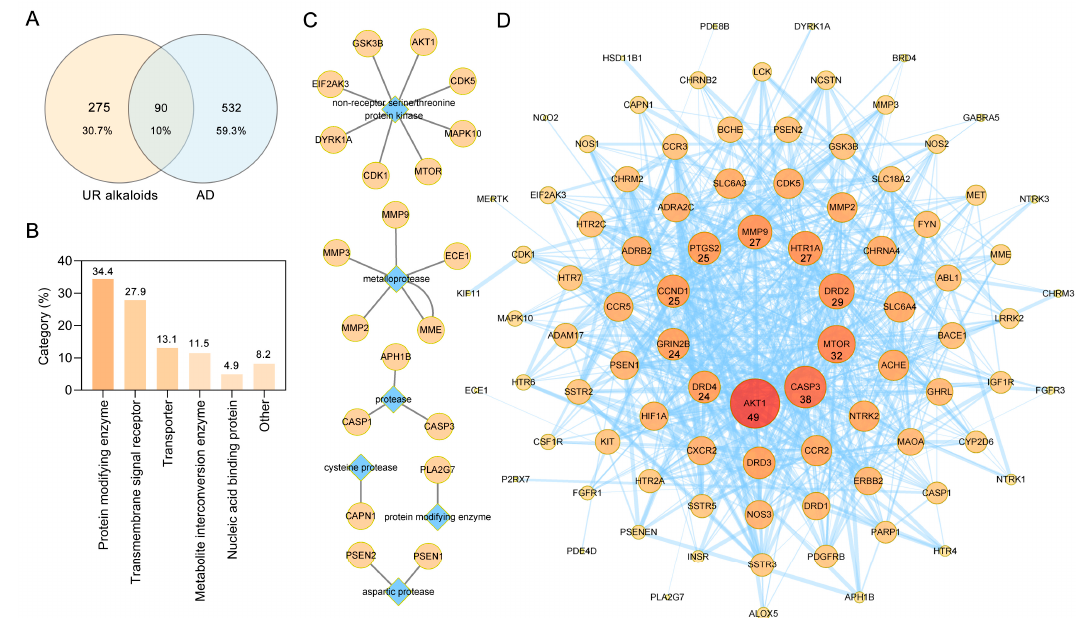
Figure 3. Protein–protein interaction (PPI) network construction for target proteins of UR alkaloids against Alzheimer’s disease (AD). ( A ) A Venn diagram was applied to obtain the intersection between the 10 UR alkaloids and AD targets. ( B ) Panther classification was used categorize common targets of UR alkaloids against AD. ( C ) Target proteins involved in protein modification as enzyme (PC00260). ( D ) PPI network of UR alkaloids against AD. Nodes represent target proteins, and edges represent interactions among targets. The numbers below the nodes indicate the degree. The darker the color and the larger the node are, the greater the degree is. Table 2. Targets of UR alkaloids against AD.